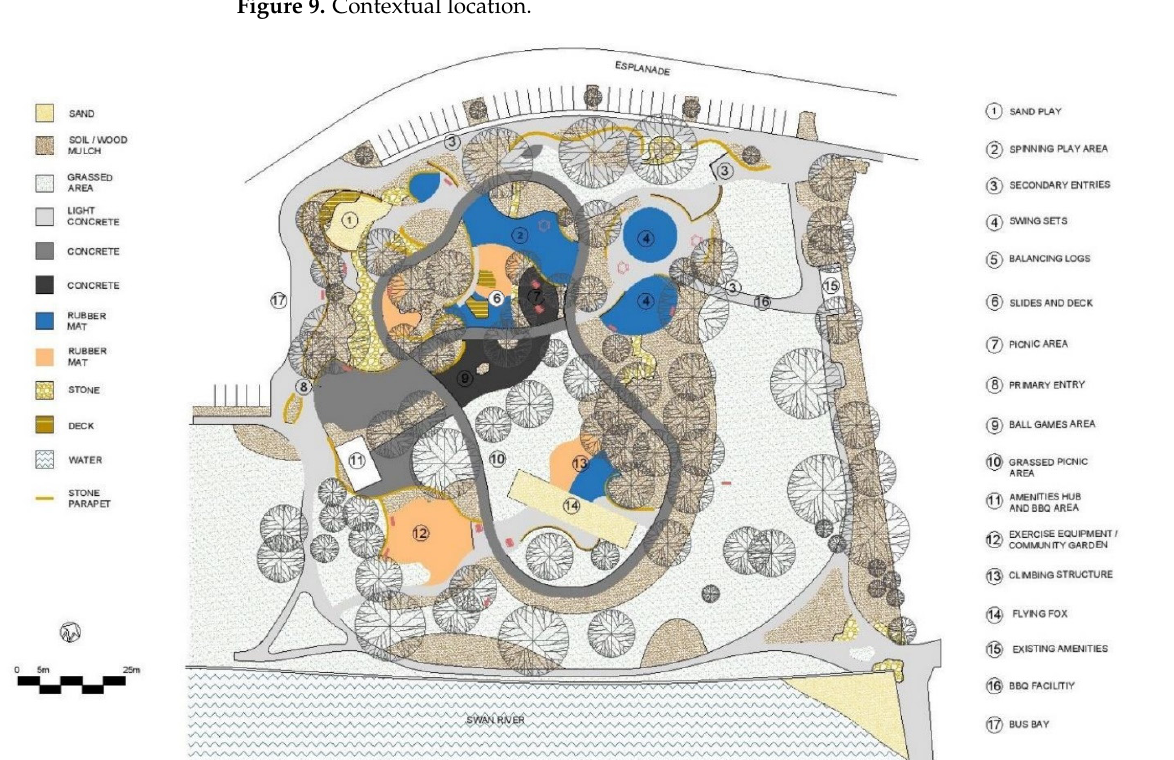
Table 2. Temperature History (information supplied by Weatherzone based on data from the Bu- reau of Meteorology) [35].